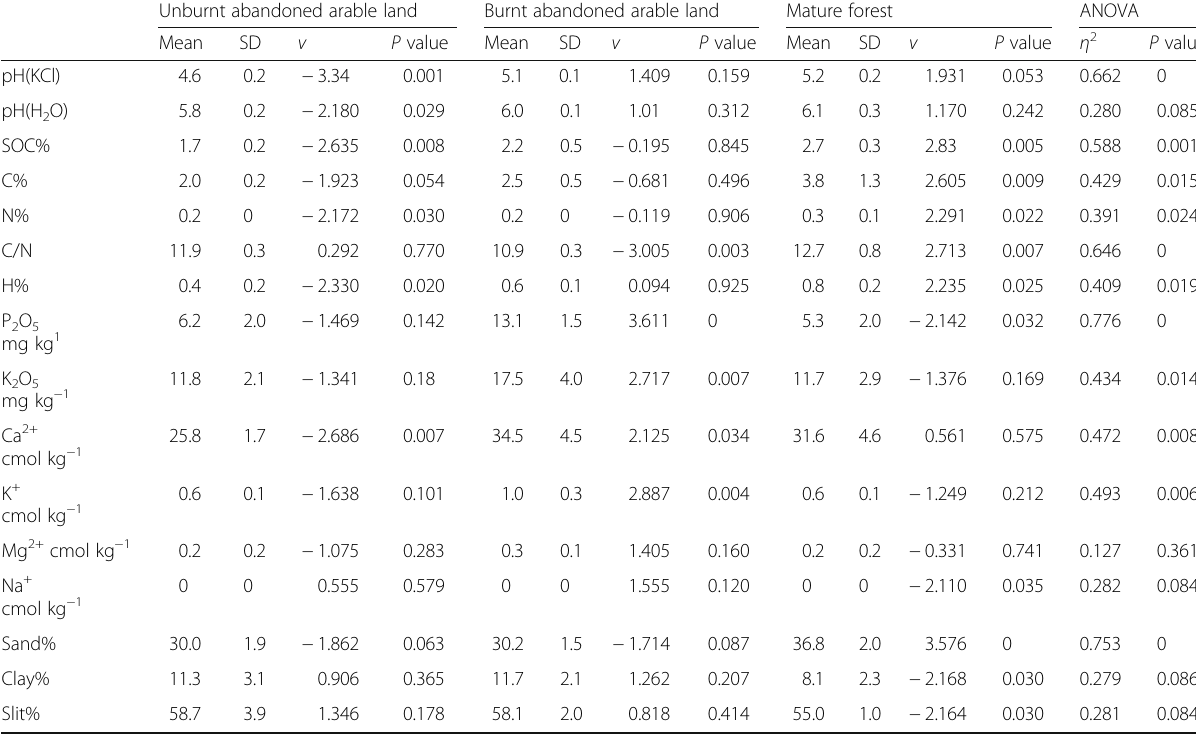
Table 3 Chemical and physical properties of the top (0 – 10 cm) soil in the studied biotopes and results of v test and one-way ANOVAs; n = 6; SD standard deviation; η 2 effect size; v statistics of the v test Unburnt abandoned arable